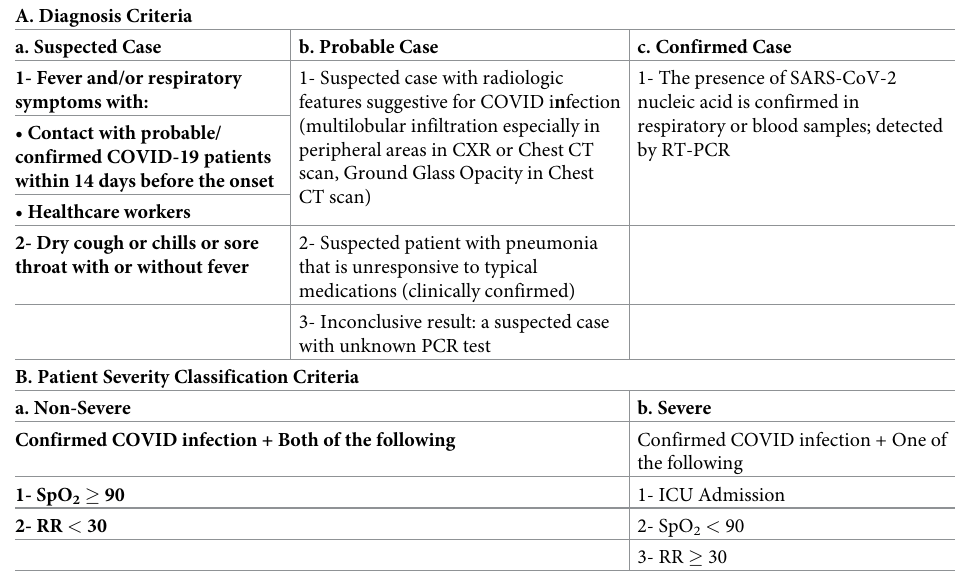
Table 1. Criteria for disease diagnosis and severity assessment upon hospital